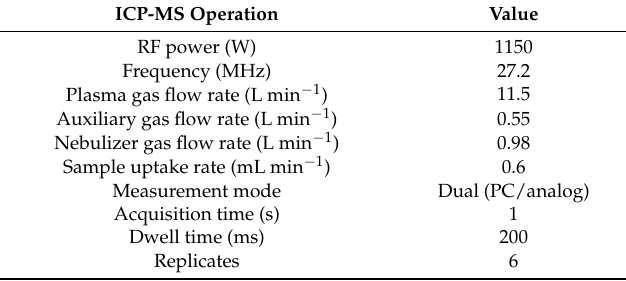
Table 2. Operating conditions for the inductively coupled plasma mass spectrometry (ICP–MS) measurements.